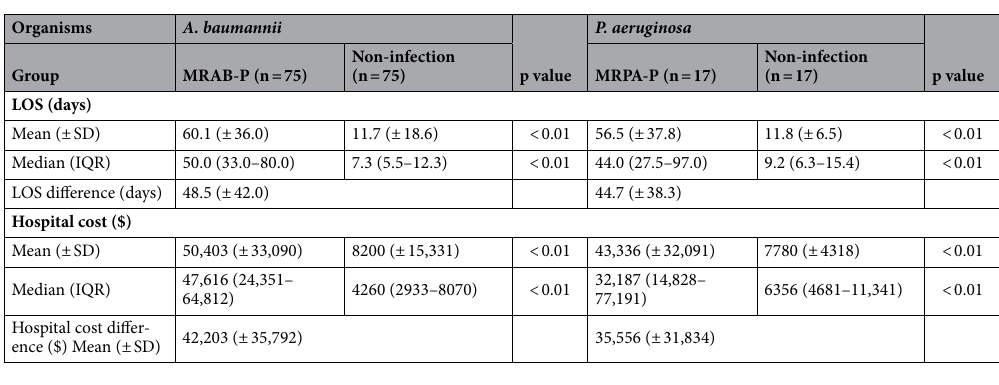
Table 3. Differences in costs and length of hospital stay between patients with multidrug resistant organisms’ pneumonia and no infection. MRAB-P multidrug resistant A. baumannii pneumonia, MDR multidrug- resistant, MRPA-P multidrug resistant P. aeruginosa pneumonia, LOS length of stay, IQR interquartile range, SD standard deviation.